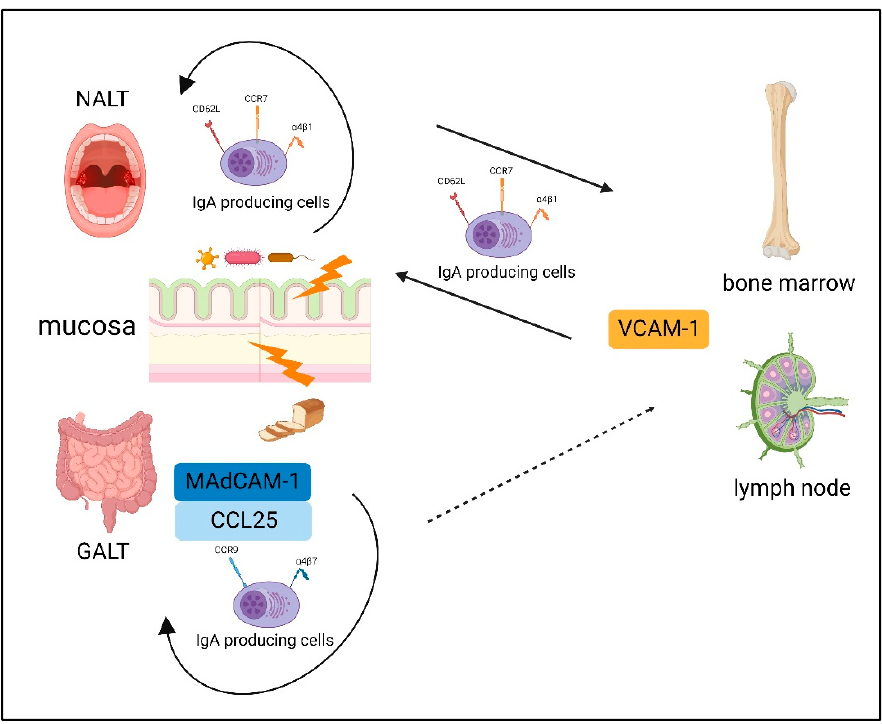
Figure 2. The basic dichotomy of B-cells homing. The expression patterns differ between IgA-producing B cells stimulated in the NALT and those stimulated in the GALT. The GALT induced CC Chemokine Receptor (CCR) 9 and α 4 β 7 upregulation, which directs their homing to locations in the small intestine expressing mucosal-addressing cell adhesion molecule (MAdCAM)-1 and C-C motif chemokine ligand (CCL) 25. NALT induces the expression of α 4 β 1, which interacts with vascular cell adhesion molecule (VCAM)-1, and the molecules l-selectin (CD62L) and CCR7, resulting in systemic homing. Created with BioRender.com.